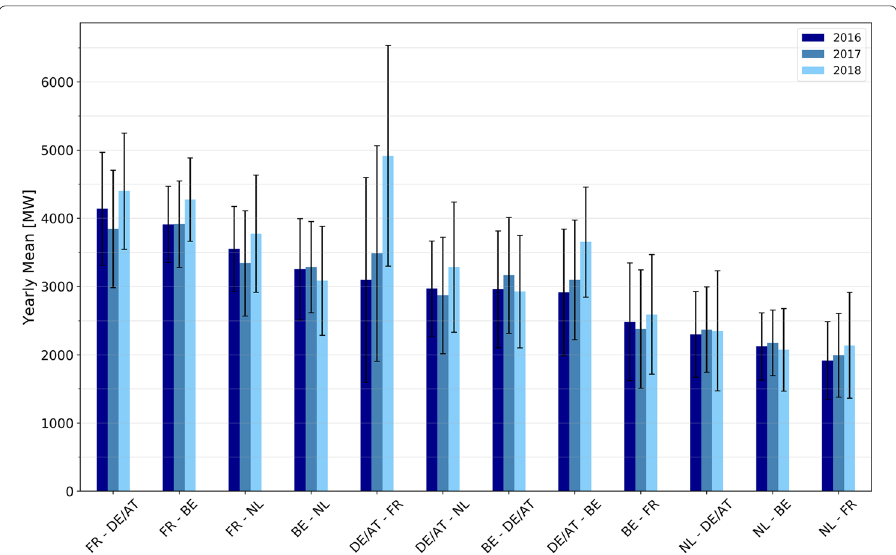
Fig. 2 Arithmetic mean and standard deviation of MAXBEX capacities on all links. Note that capacities are not symmetric, i. e. MAXBEX from one country to the other is not the same as from the latter country to the